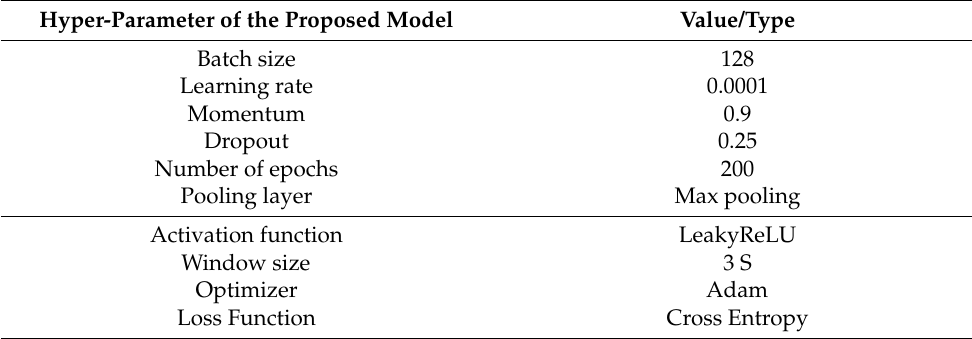
Table 1. The value or types of the proposed model’s hyper-parameters.